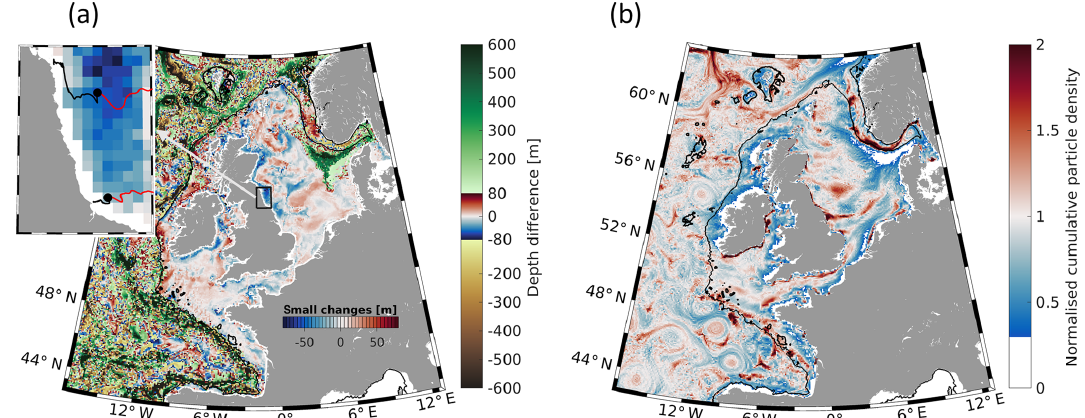
Figure 8. (a) Difference of the final depth minus the initial depth of bottom-released particles after 1 month (January) in 2015 in the control run (CR, no. 1; see Table 1). Positive (negative) values indicate a depth increase (decrease). The model grid in which a particle was released is coloured depending on its depth change. The small figure shows a magnified view of the British coast with two exemplary bottom (black) and surface (red) trajectories starting at the big dots. The trajectories are detided with a 25h moving average. (b) Tendencies of accumulation shown as the January mean normalised cumulative particle density (NCPD) calculated from the backward simulation (CR-B, no.